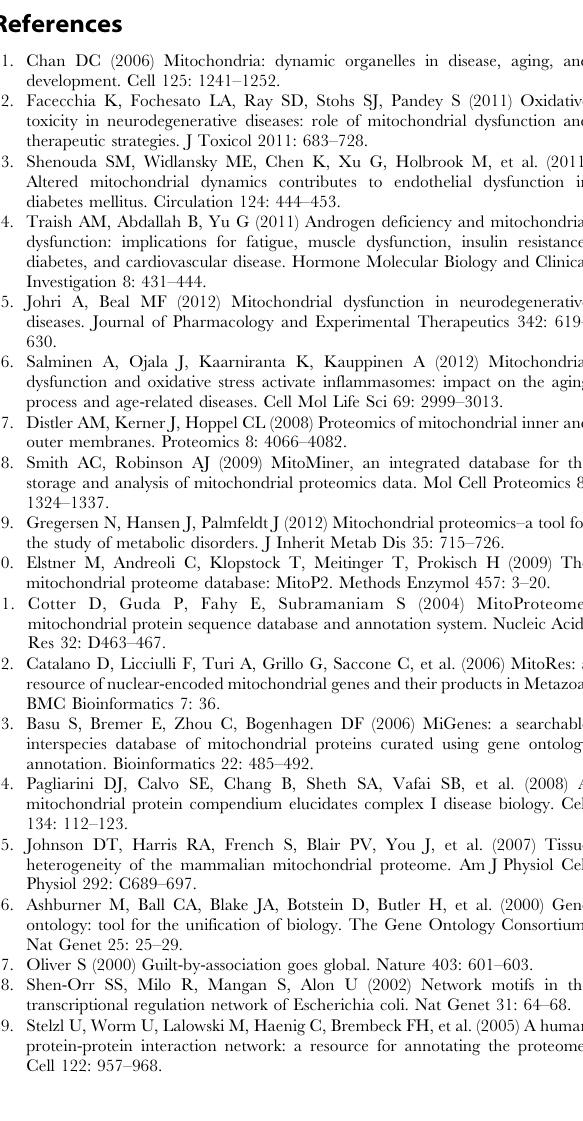
Table S3 Coverage of datasets on gold standard set. (DOC) Table S4 Pearson correlation coefficients between high coverage datasets on the gold standard set. (DOC) Table S5 Optimal parameters and corresponding performances of four algorithms on four networks. Table S6 Organisms used for phylogenetic profiles. (XLS) Method S1 Data source and processing methods of the 11 genomic features to generate